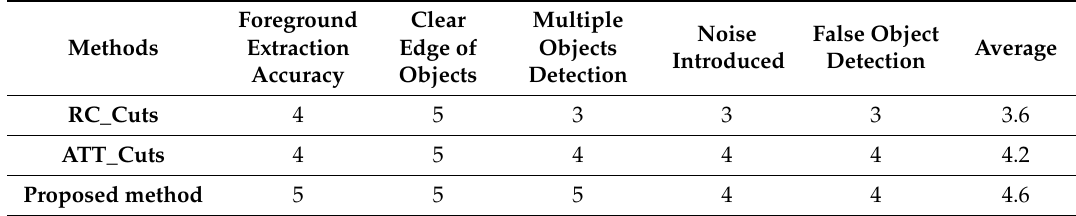
Table 2. Subjective evaluation of the proposed and other methods.